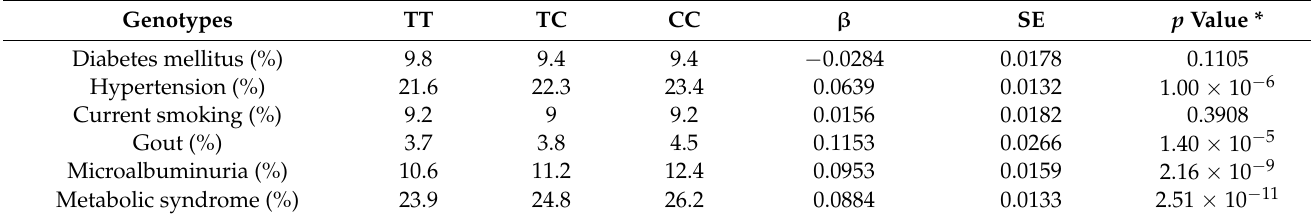
Table 2. Association between rs1260326 genotypes and atherosclerotic risk